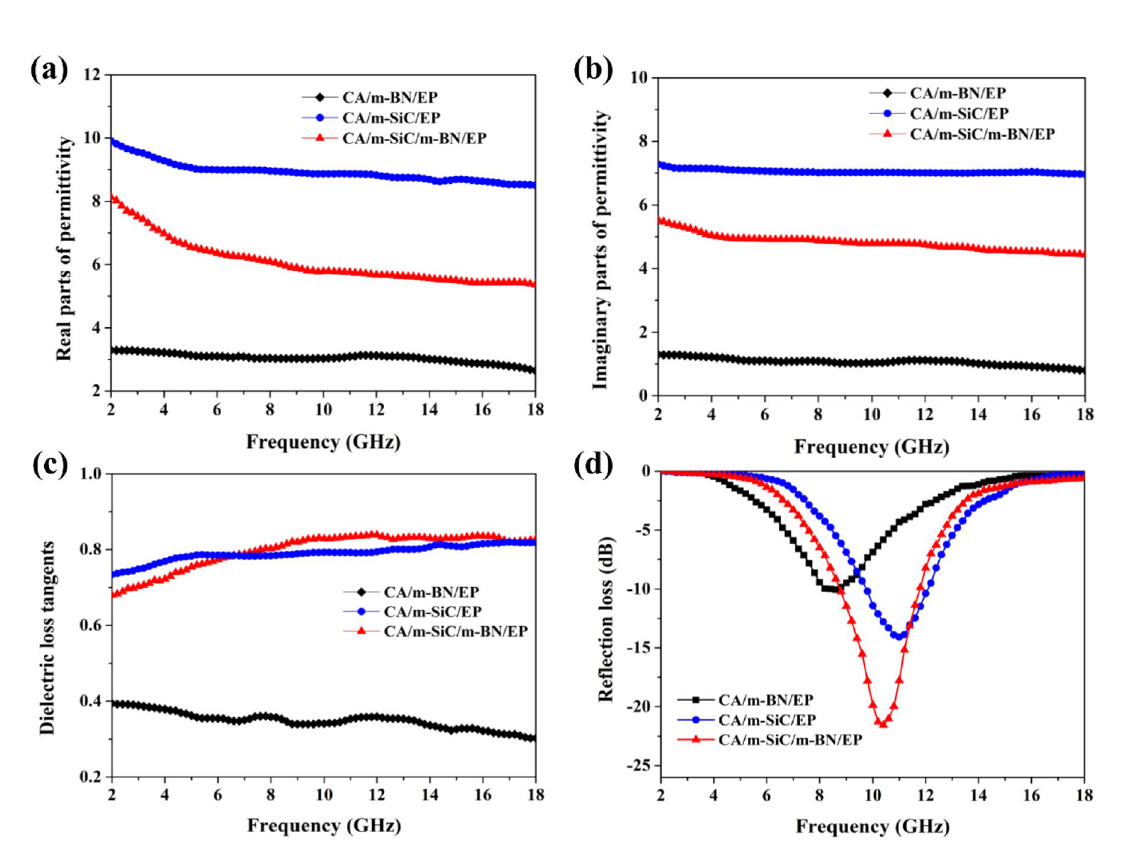
Fig. 10 a Real parts and b imaginary parts of the complex permittivities. c dielectric loss tangents and d reflection loss of the CA/m‑SiC/EP, CA/m‑BN/EP and